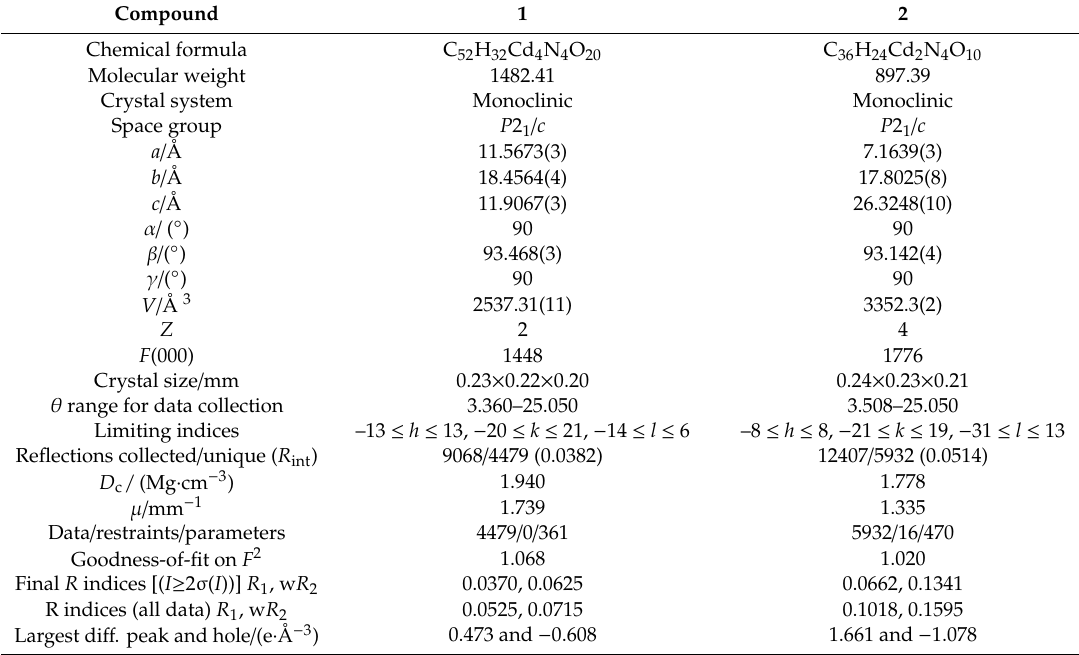
Table 1. Crystal data for coordination polymers (CPs) 1 and 2